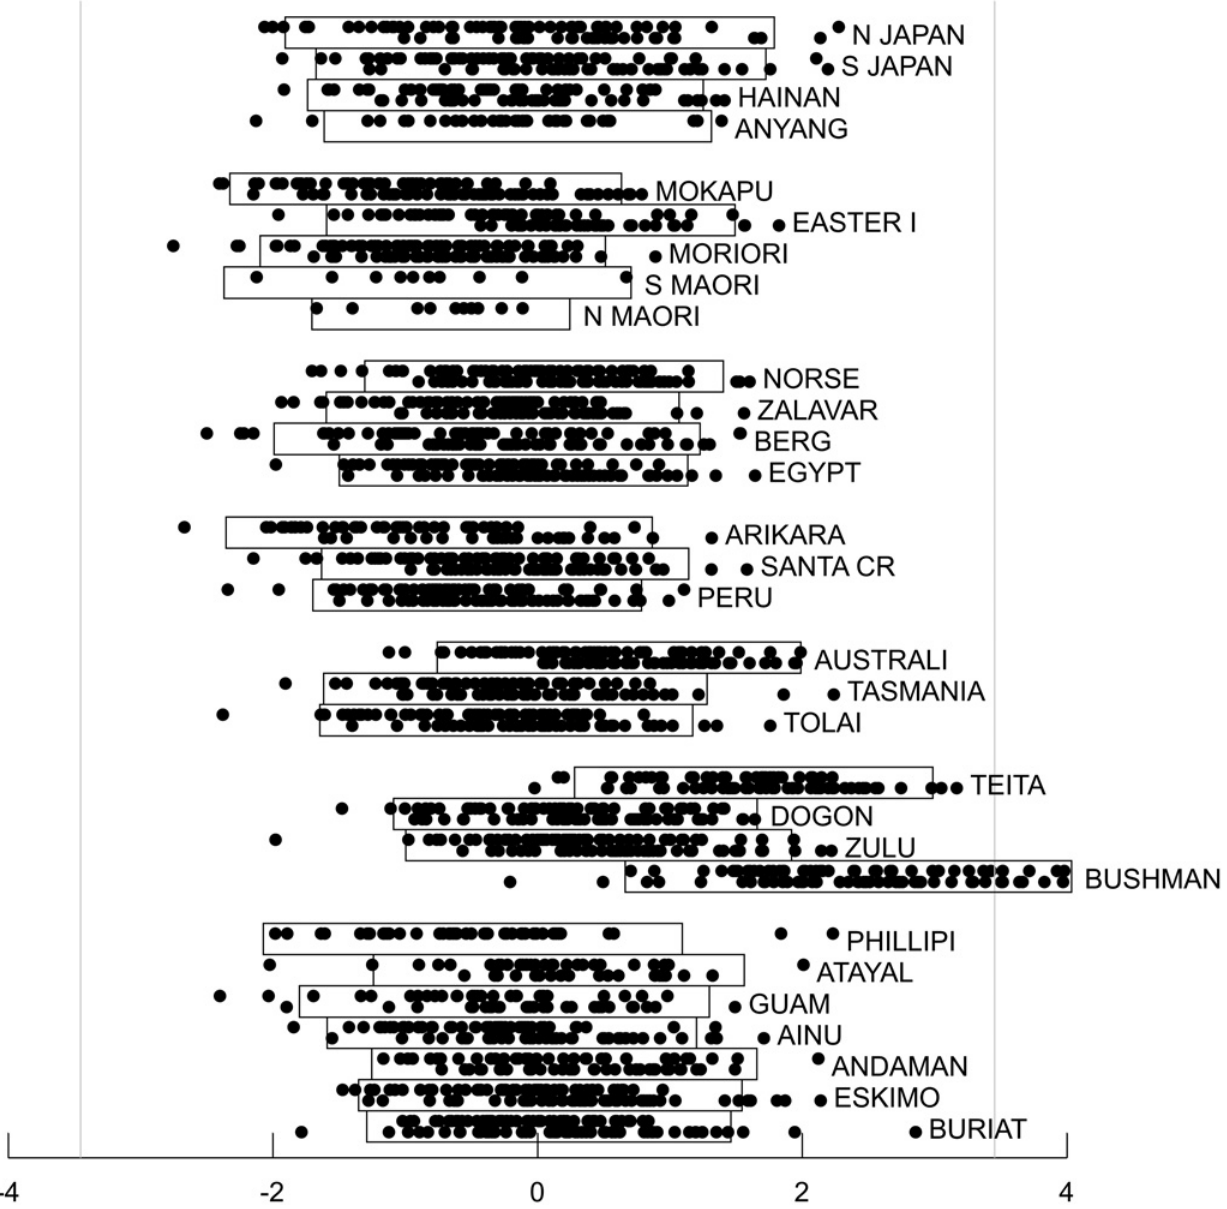
Fig 8. Super-Gaussian source separating the Bushman and Teita populations from other populations. Source scores are derived from the best fitting model. This source accounts for 18.0% of the variance of the original data set. See Fig. 6 legend for additional